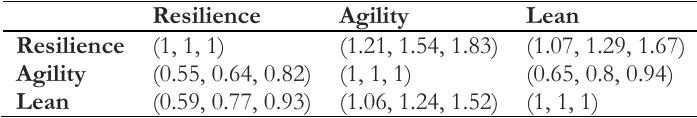
Table 7. matrix of pairwise comparisons of factors in the first level.